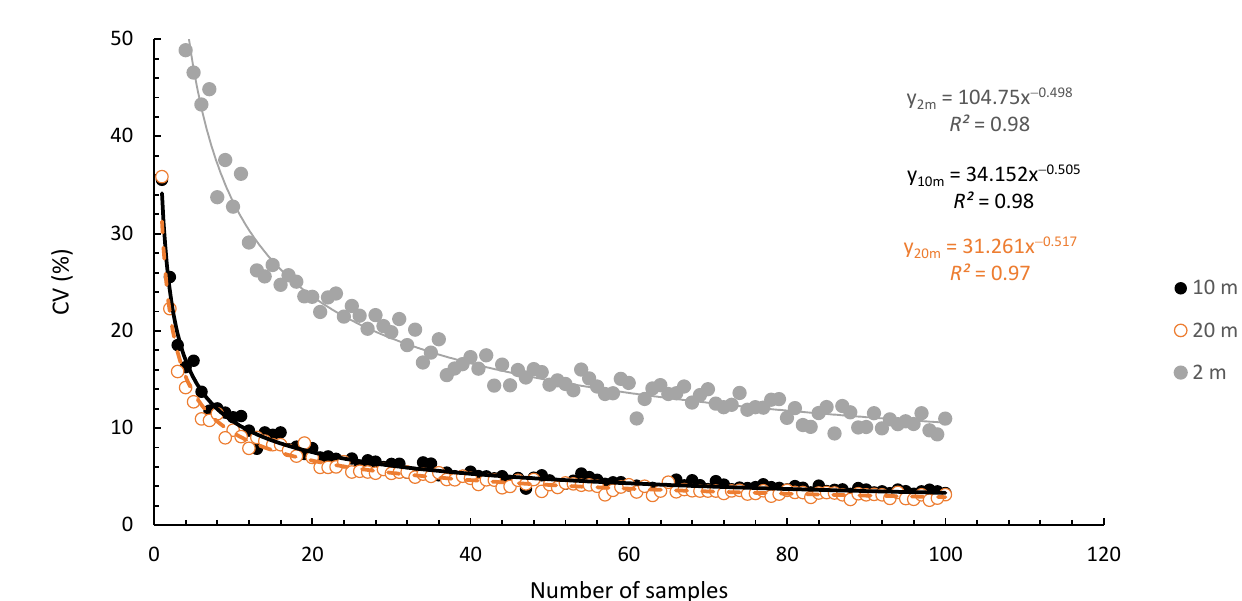
Figure 6. Improvements in precision (coefficient of variation, %) with increasing number of transects for three different transect lengths: 2, 10, and 20 m, for estimated woody debris volume of pieces from 4 to 7 cm in diameter (data from the Forest Stands where a total of 25 transects were observed). Mean of 100 simulations for each sample (dots), and the adjusted model (line).